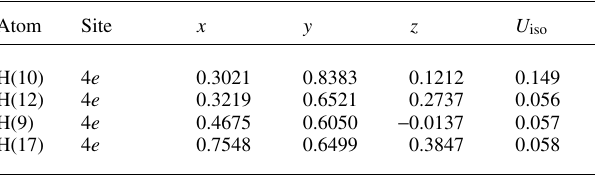
Table 2. Atomic coordinates and displacement parameters (in Å 2 ) .